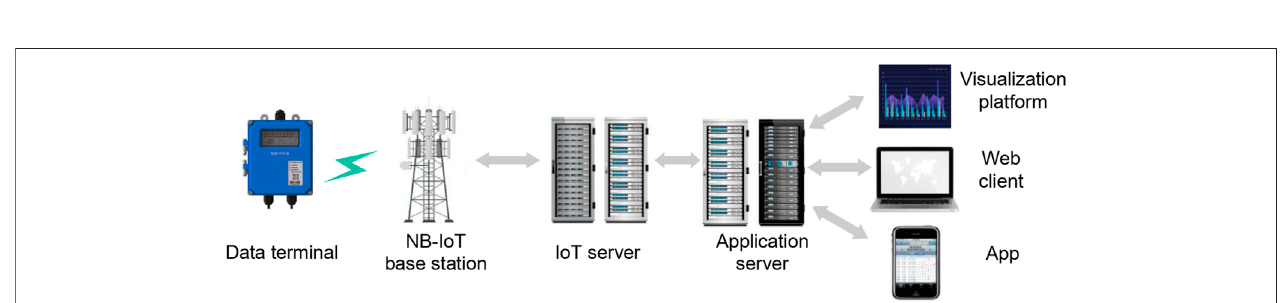
FIGURE 3 | Hardware structure of the NB-IoT encrypted data terminal.